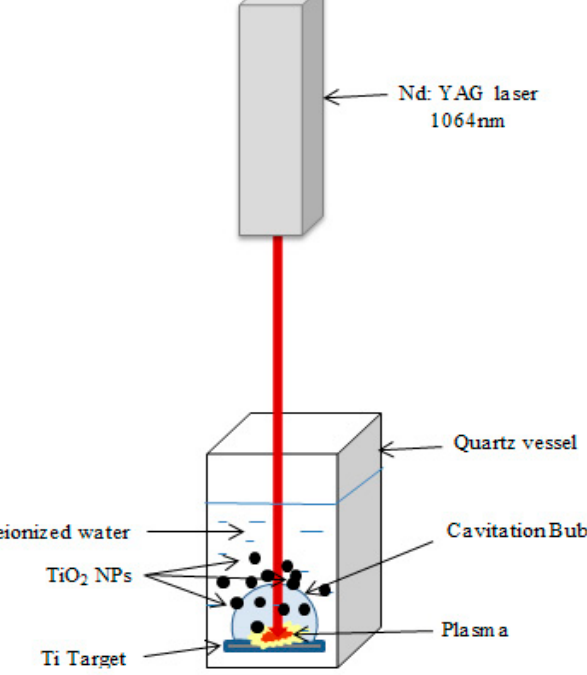
Figure 1. Schematic illustration of the experimental set-up of TiO 2 NPs suspension preparation at ambient temperature .